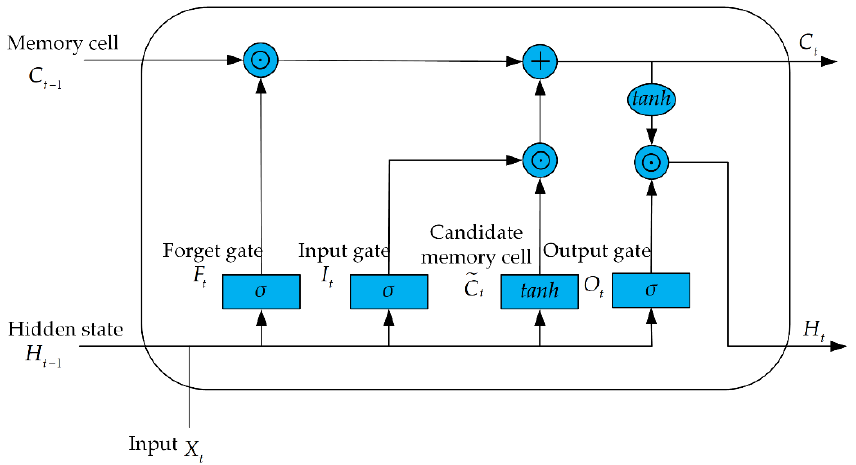
Figure 12. LSTM unit structure.